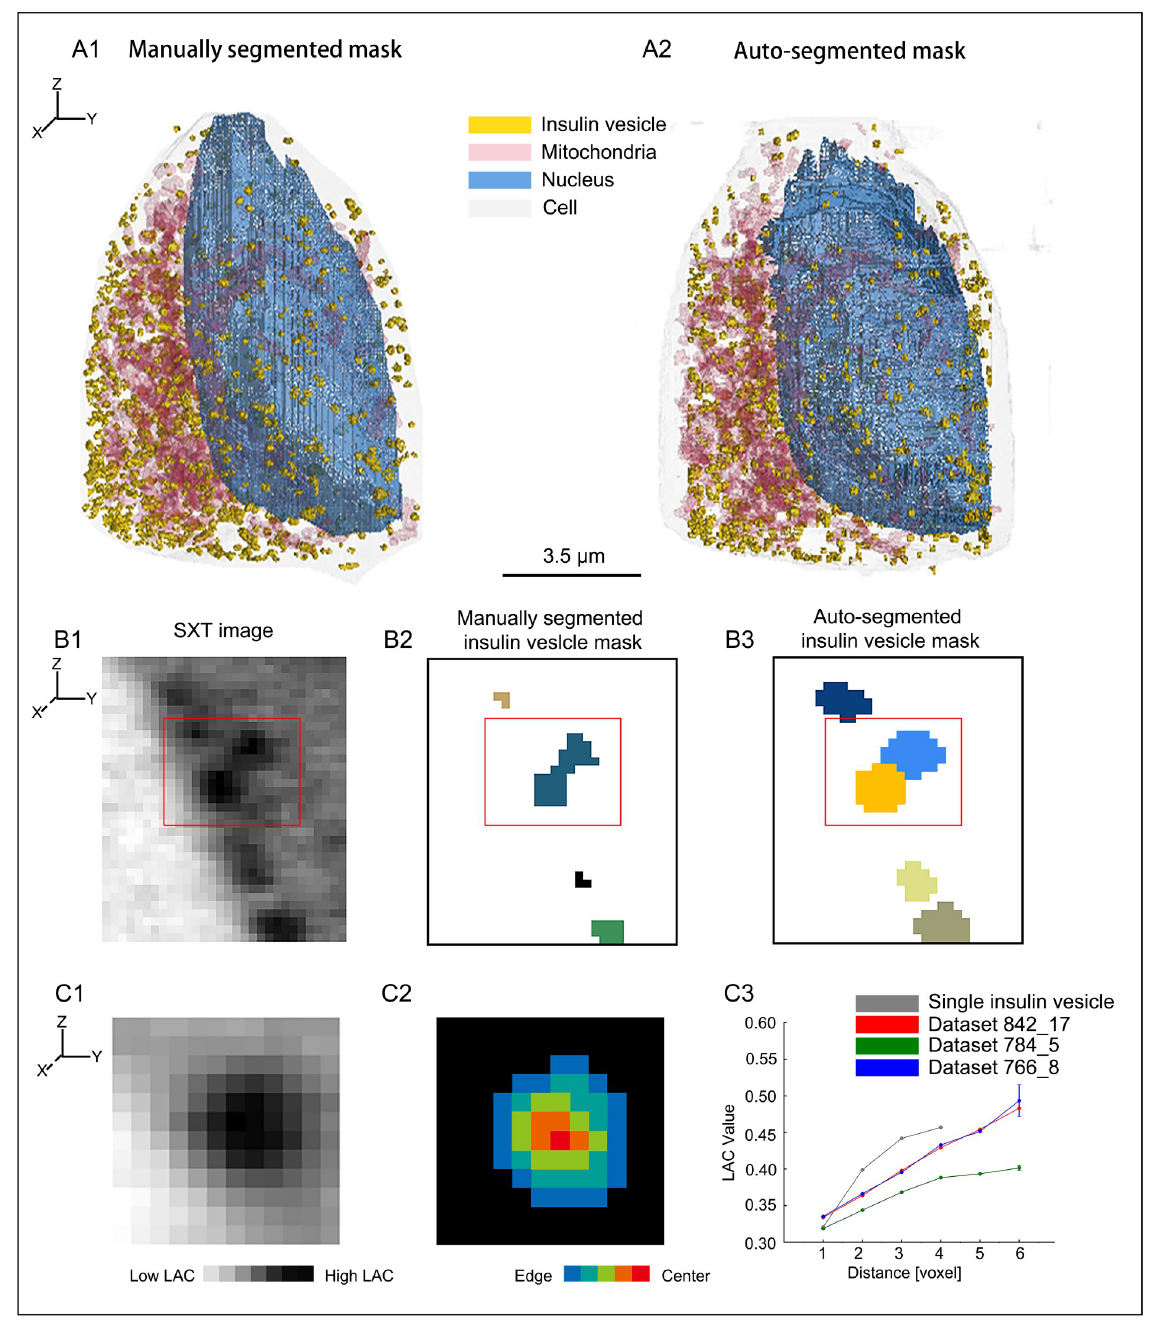
Fig 2. Example of auto-segmentation and performance on the test dataset. (A1-A2) 3D visualization to represent labels for Cell ID 766_8: (A1) manually segmented labels and (A2) auto-segmented labels. (B1-B3) Cropped 2D orthoslice of raw soft X-ray tomogram for Cell ID 842_17. Red box shows two vesicles near the plasma membrane (B1). Manually segmented mask where two vesicles are merged into one (B2). Auto-segmented mask showing correct prediction based on instance segmentation (B3). Each color represents a single instance. (C1-C3) 2D orthoslice of single insulin vesicle instance from soft X-ray tomogram of Cell ID 842_17. The voxel with the highest linear absorption coefficient (LAC) value was assigned as the center of the vesicle. LAC map of the vesicle and surrounding pixel (C1). Distance map from vesicle boundary (C2). Average LAC vs. distance of the vesicle instance from C2 shown as “Single insulin vesicle” (C3). Average LAC distribution for 3 test cells is also plotted in C3.